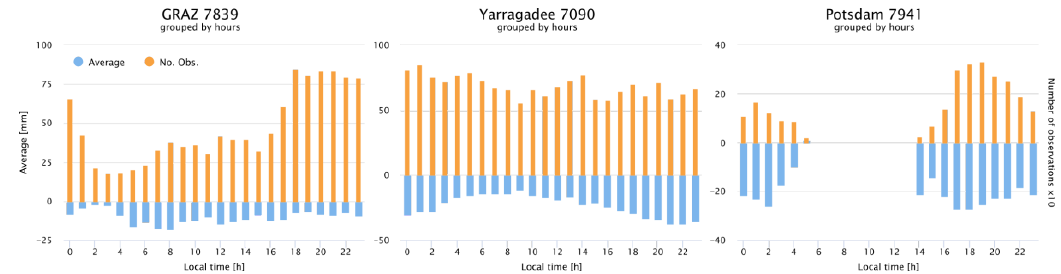
Figure 7. Relationship between local time on the laser station and both average SLR residuals and number of generated observations on selected laser stations; Dataset from October 2015–July 2017, consisted of only SLR residuals related to GLONASS-M satellites with uncoated LRA. Abbreviations used: No. Obs., number of observations.